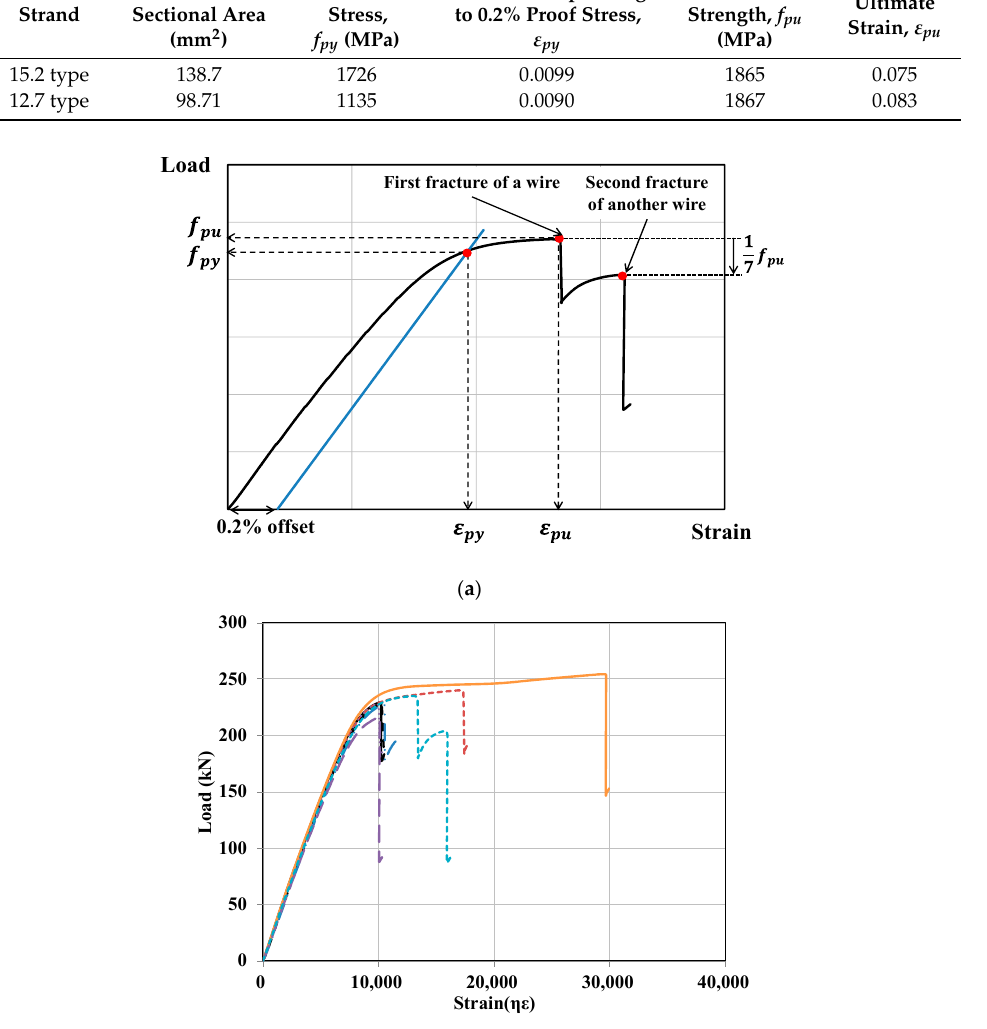
Figure 11. ( a ) Load–strain curve of a corroded strand and ( b ) samples from specimens.